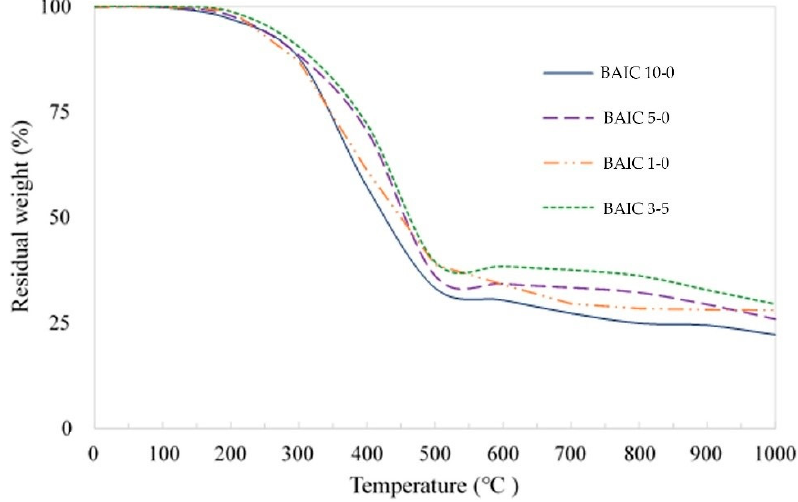
Figure 5. Thermogravimetric analysis (TGA) curves of BAIC samples.